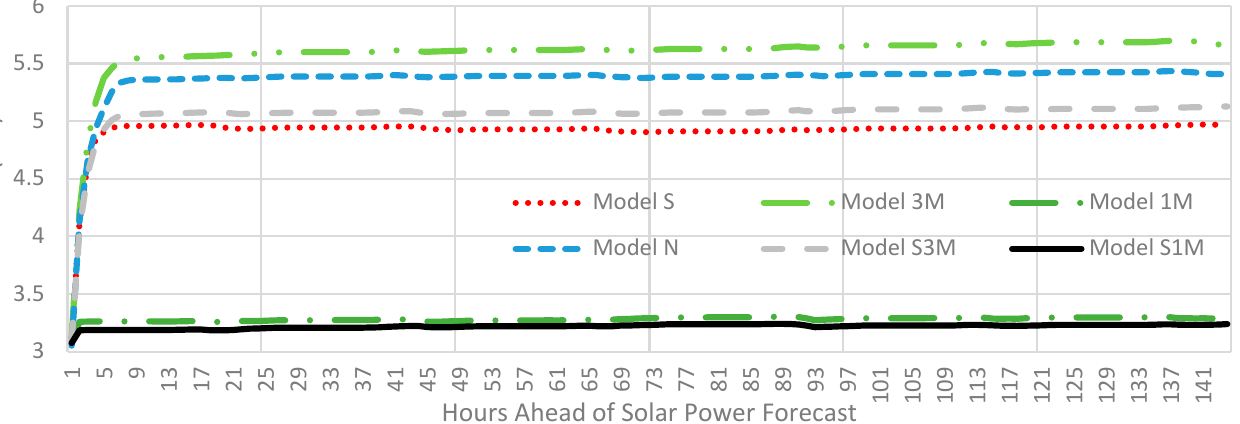
Figure 5. RMSE of hours ahead predictions of the six CatBoost scenarios.